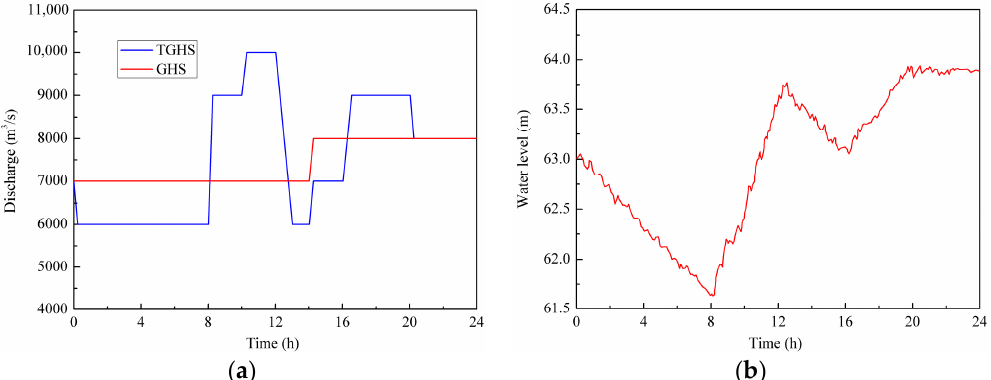
Figure 16. Boundary conditions. (a) Daily regulation between the TGHS and GHS; (b) Water level at the Xitan Station.